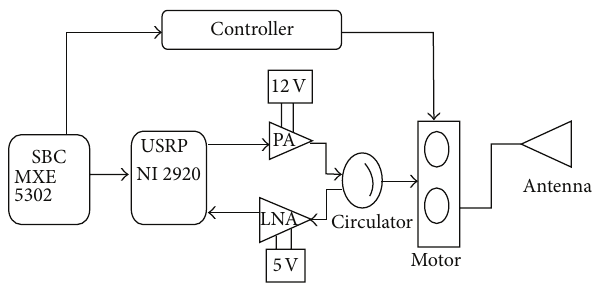
Figure 1: Block diagram of the proposed SDRadar